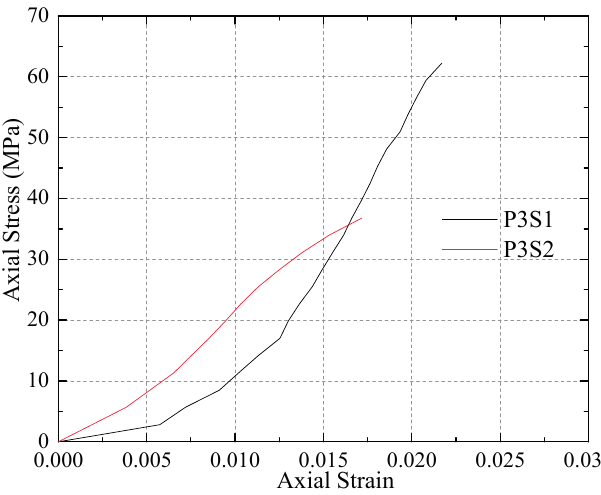
Figure 8. Axial stress versus axial strain curves of the reloaded confined